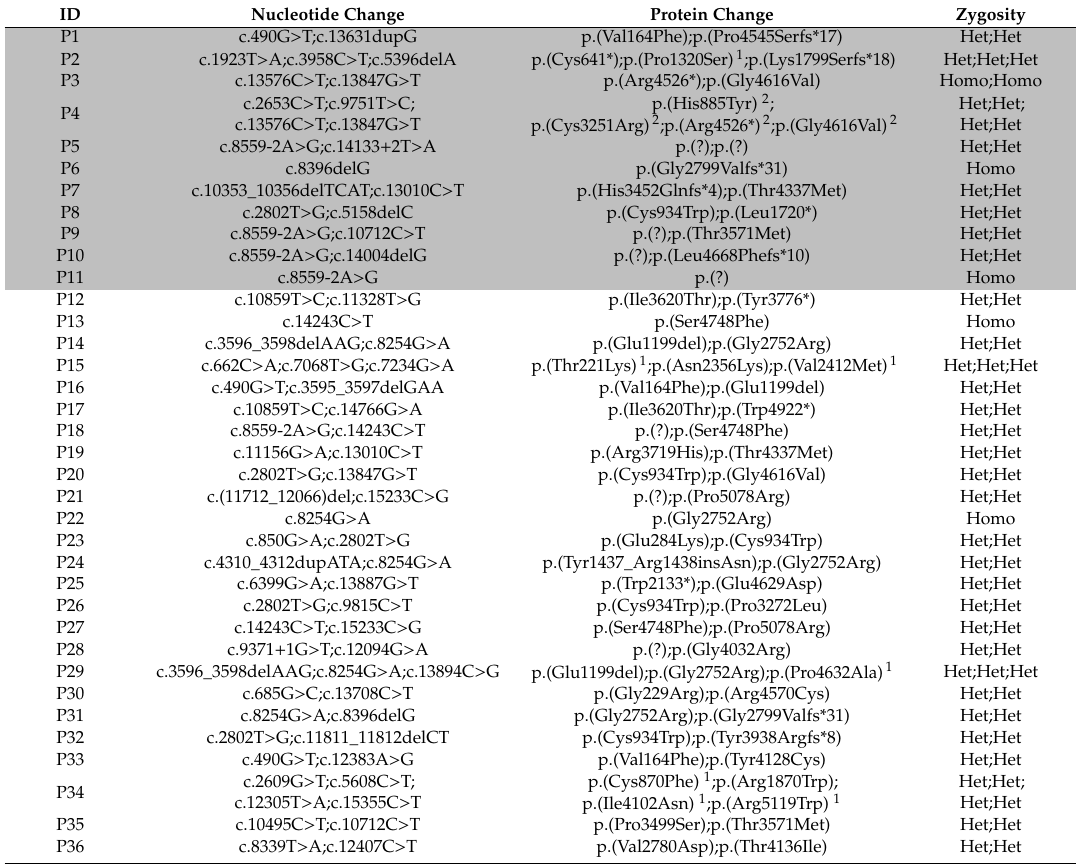
Table 1. USH2A variants detected in RP patients in this study.